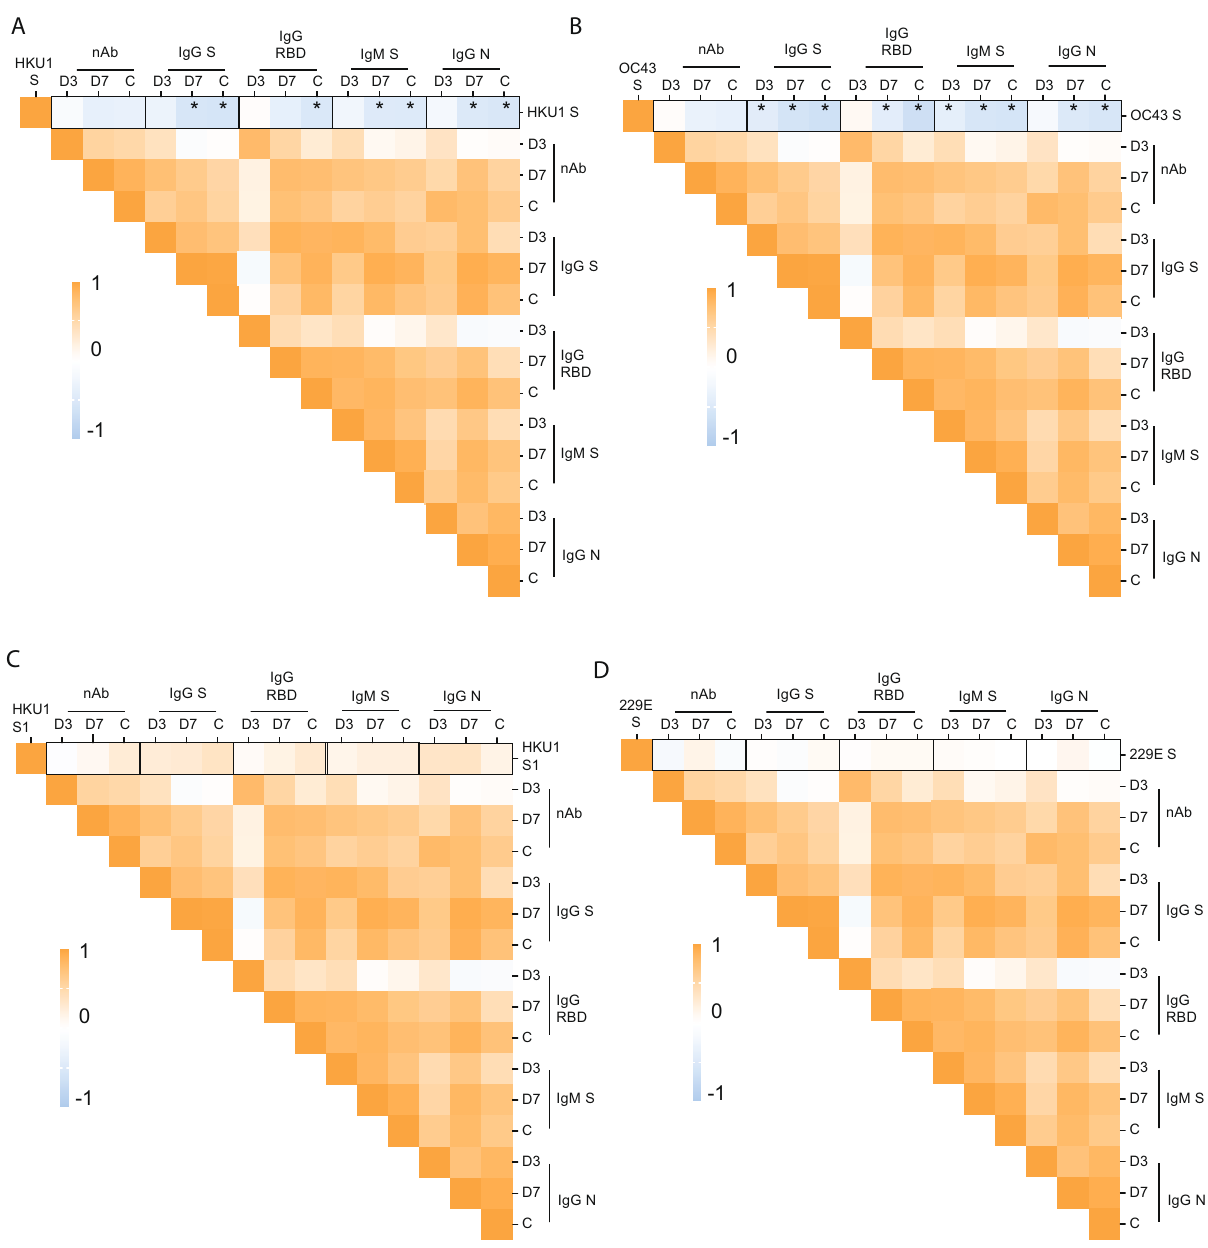
Fig. 5 Immunological imprinting on SARS-CoV-2 antibody response. A , B Heat map of Pearson correlation matrices between pre-existing levels of seasonal hCoV (A IgG HKU1 S; and B IgG OC43 S) and fold induction of SARS-CoV-2 antibodies at each time point: neutralizing (nAb), IgG spike, IgG RBD, IgM spike and IgG NP. Statistically signi fi cant correlations in the underlined intersections are indicated with asterisk (*); D3: day 3; D7: day 7; C: convalescence. C , D Scatterplot of baseline IgG levels for HKU1 and OC43 S protein and fold induction of SARS-CoV-2 antibodies: neutralizing (nAb), IgG spike, IgG RBD. Overlay shows relationship with induction of de novo antibodies against SARS-CoV-2 at each time point. Fitted linear regression